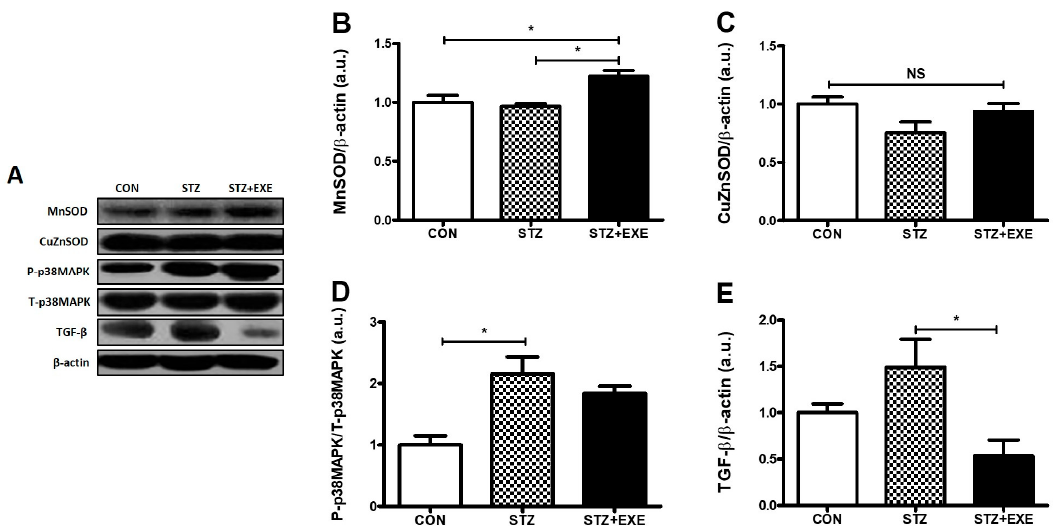
Figure 4. Aerobic exercise increased MnSOD levels and decreased TGF- β levels in the liver of type 1 diabetic rats. ( A ) Representative western blot. ( B ) Western blot analysis of liver MnSOD, ( C ) Western blot analysis of liver CuZnSOD, ( D ) Western blot analysis of liver p-38MAPK, ( E ) Western blot analysis of liver TGF- β . Results are expressed as the mean ± SE. * p < 0.5; NS, not significant.